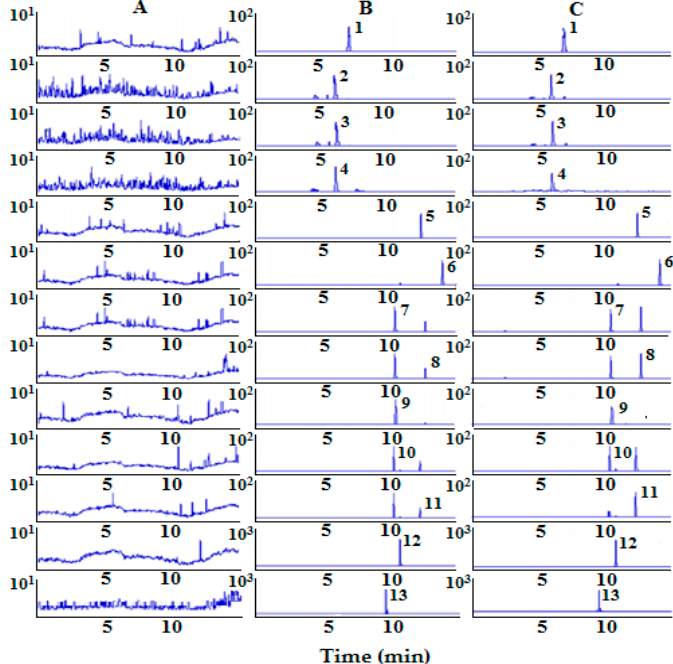
Figure 1. SRM chromatograms of magnoflorine (1), neochlorogenic acid (2), chlorogenic acid (3), cryptochlorogenic acid (4), baohuoside II (5), baohuoside I (6), epimedin B (7), sagittatoside B (8), epimedin C (9), epimedin A (10), sagittatoside A (11), icariin (12) and IS (13). ( A ) Blank plasma; ( B ) blank plasma spiked with the analytes and IS; ( C ) plasma sample 15 min after oral administration of Epimedium extract.